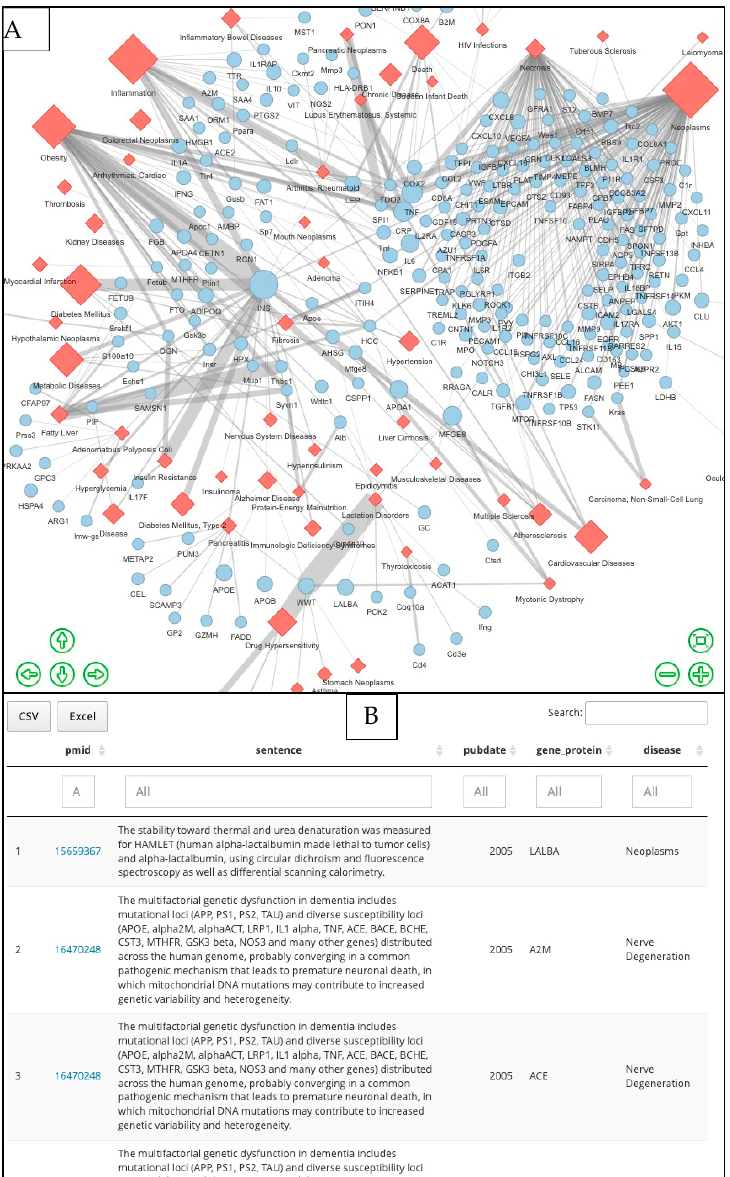
Figure 3. Protein–Disease Network and Protein–Disease Comention. ( A ) The protein–disease comention network from the nutrition–proteomic corpus, restricted to those protein–disease pairs with five or more supporting references (for plotting clarity). Blue circles are proteins and orange diamonds are diseases. The size of the symbols is proportional to the number of mentioning publications in the corpus. The edges are similarly scaled to represent the number of unique publications comentioning the two entities. An interactive network is in File SA, Figure S5.1. ( B ) Screenshot of File SA, interactive Table S5.2 with the PubMed ID (pmid), the extracted sentence, publication date, the gene/protein, and the disease. PMIDs retain links to the PubMed abstracts. Individual columns can be sorted (arrows in column headings) and searched.